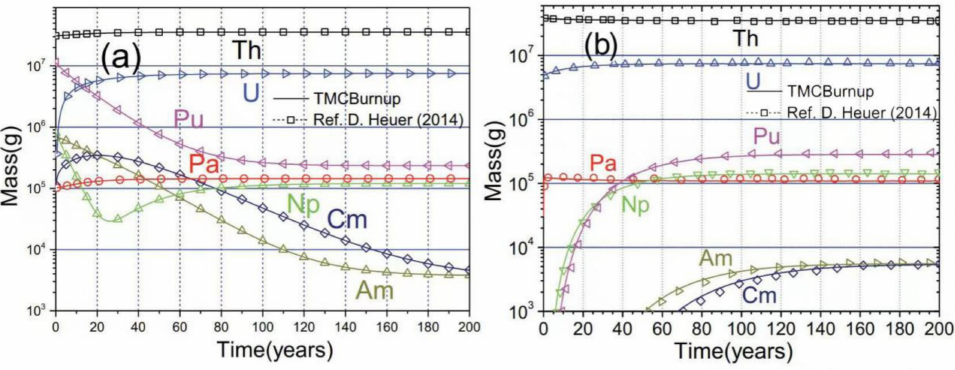
Figure 4. Evolution of heavy nuclides for MSFR started with TRU ( a ) and 233 U ( b